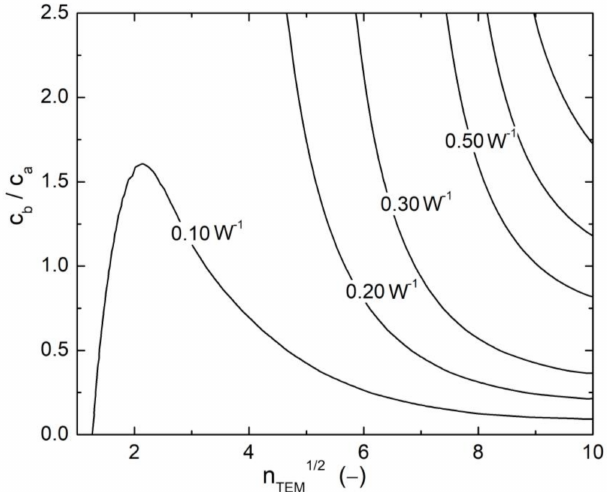
Figure 11. Contours of cost per watt c n / P ATEG normalized to the cost of an ATEG formed with a single TEM c 1 ; units W − 1 , as a function of the proportional vs invariable cost ratio c b / c a , and of the square root of the number of TEMs n TEM used in the